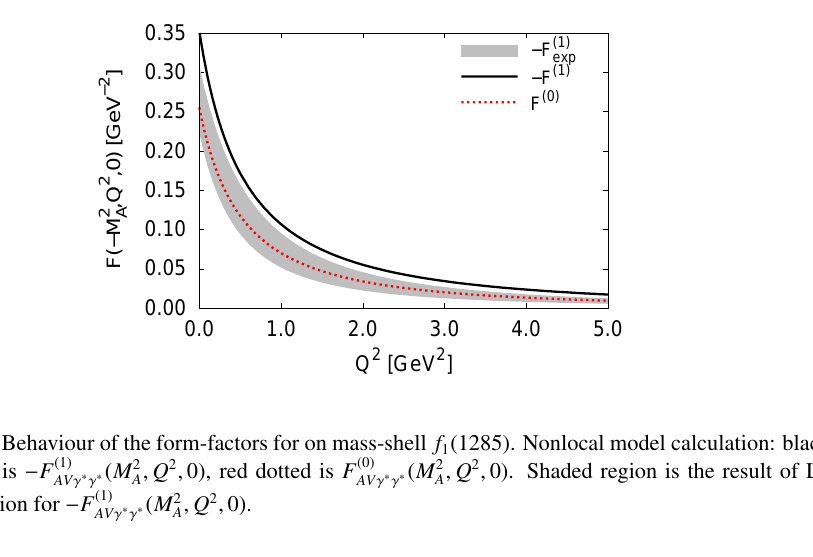
, Q 2 , 0). Shaded region is the result of L3 ( M 2 A AV γ ∗ γ ∗